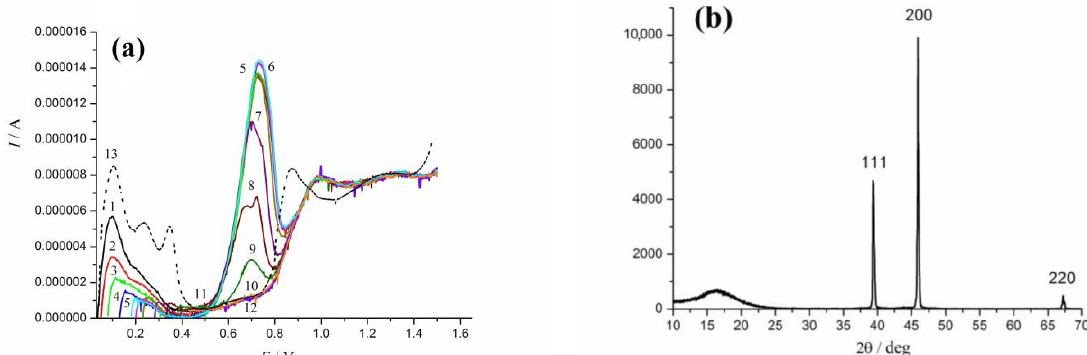
Figure 3. Anode branches of cyclic voltammograms (CVA) curves ( a ) in water saturated with CO 2 after the delay of potentials E in Volts (the number of curve): black line: 0. 03 (1); red line: 0.05 (2); green line: 0.08 (3); blue line: 0.130 (4); cyan line: 0.180 (5); magenta line: 0.200 (6); dark yellow line: 0.230 (7); purple line: 0.280 (8); wine line: 0.330 (9); olive line: 0.380 (10); orange line: 0.430 (11); violet line: 0.480 (12). Dotted black line (13): anode branch of CVA curve in 1.95 × 10 − 4 M HClO 4 solution after a delay of the initial potential of 0.03 V. Scan rate 0.01 Vs − 1 . ( b ) The diffractogram for (pc)Pt electrode.